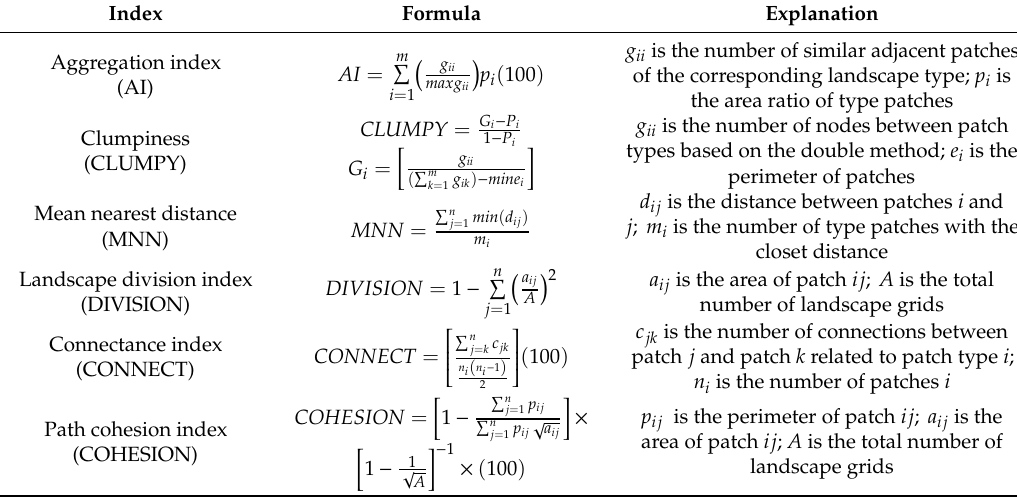
Table 3. Landscape spatial structure